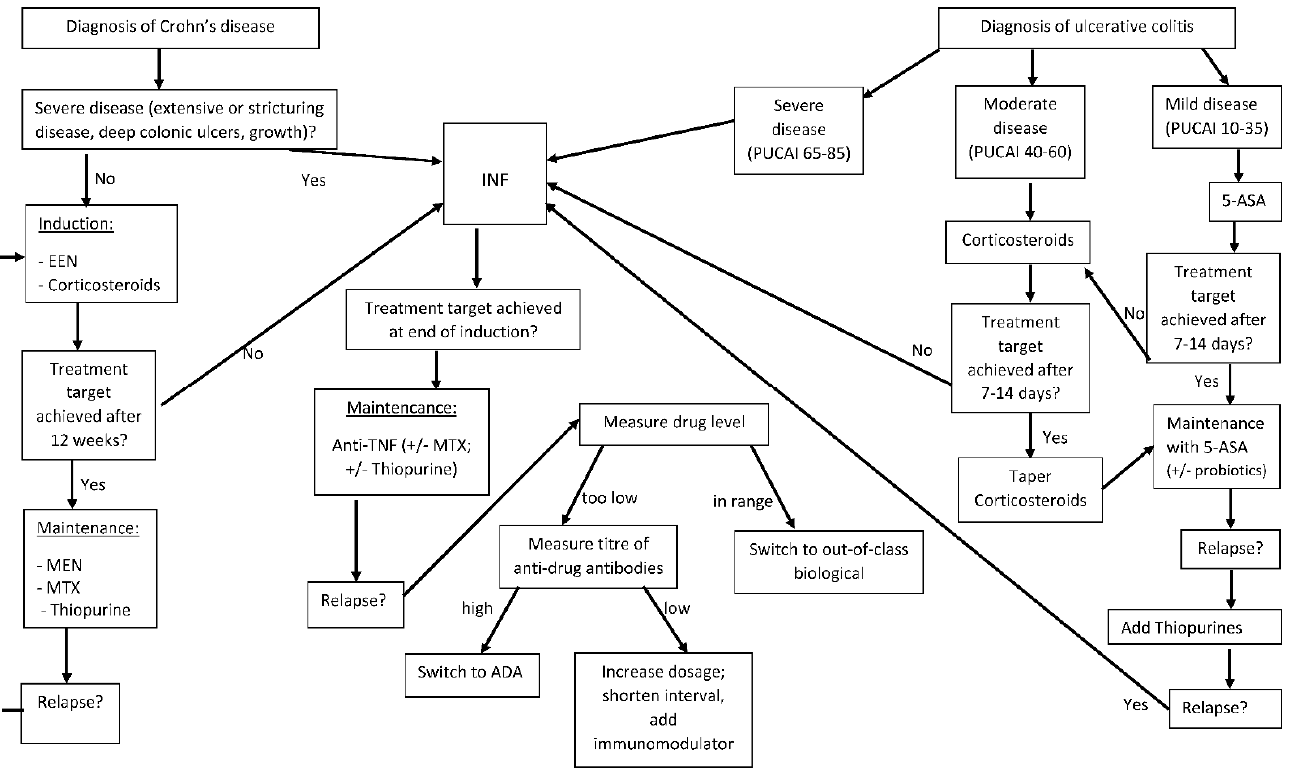
Figure 1. Treatment in paediatric IBD. IFX: infliximab, ADA: adalimumab, EEN: exclusive enteral nutrition, PUCAI: paediatric ulcerative colitis activity index. Adapted from ECCO/ESPGHAN Guidelines for management of paediatric IBD.